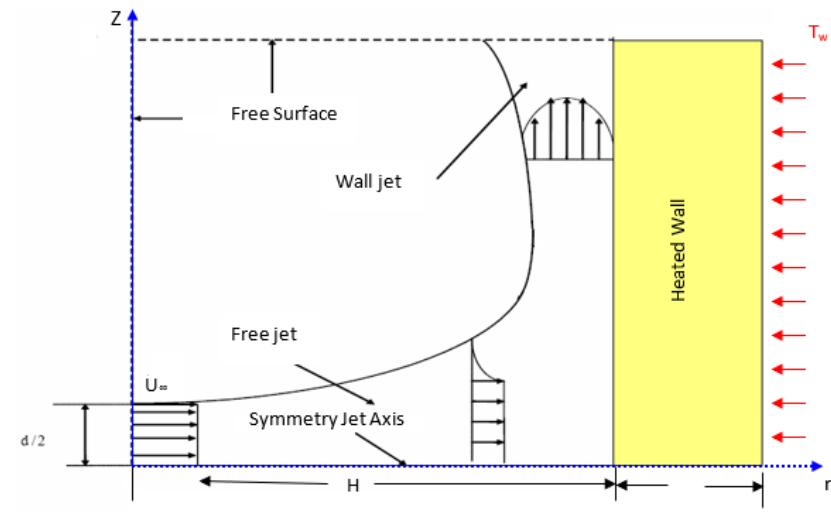
Figure 1. Geometry and computational domain.